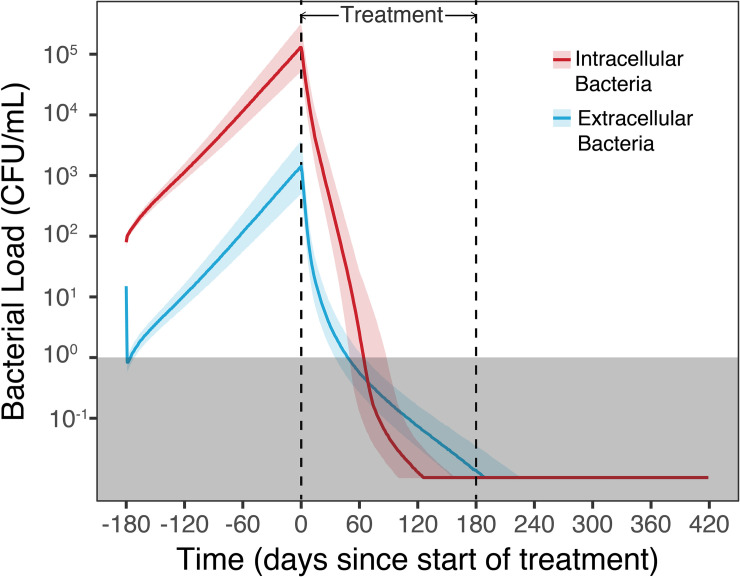
Intra- vs. extracellular bacterial load in TB infection.Intra- and extracellular bacteria count in lung tissue for TB infection with standard drug therapy (2HREZ/4HR). The TB infection occurs on day -180, and drug therapy is started on day 0, triggering rapid intra- and extracellular bacterial death. The grey shaded block represents the cut-off of CFU/ml equal to 1 for a patient to be considered cleared of bacteria at the end of treatment.